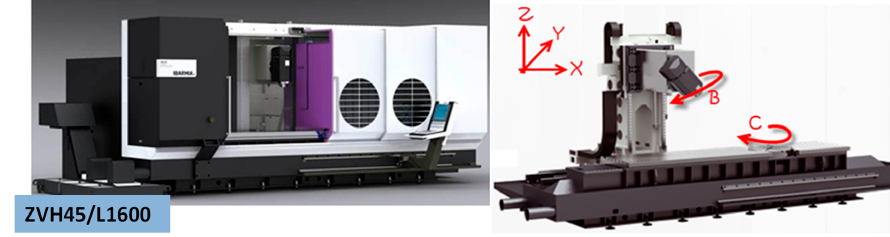
Figure 1. Ibarmia ZVH45/L1600 ADD + PROCESS kinematic.